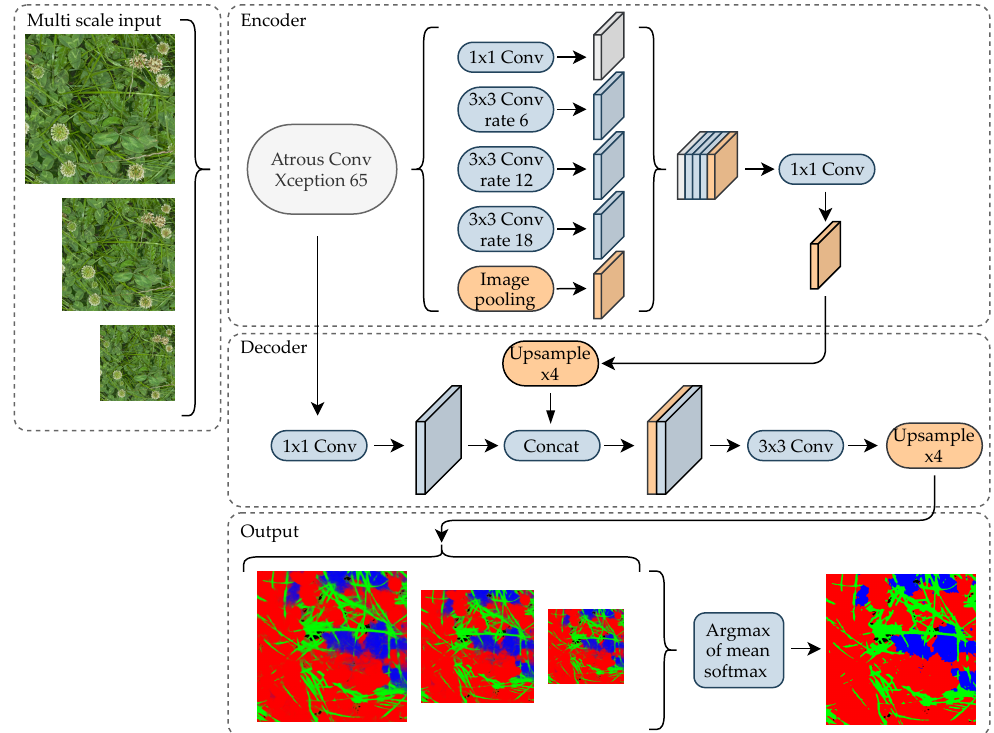
Figure 4. Overview of the Deeplab v3+ [20] neural network architecture. Features from the Xception 65 [21] based backbone is concatenated at multiple scales in the encoder using spatial-scale adjustable atrous filters. The decoder combines higher resolution features from within the Xception 65 with the multi-scale features to produce a spatially improved semantic segmentation. To further improve scale- invariance, images are processed at three image scales and averaged to a final class probability map. The encoder–decoder model architecture is illustrated with similarities to the original publication